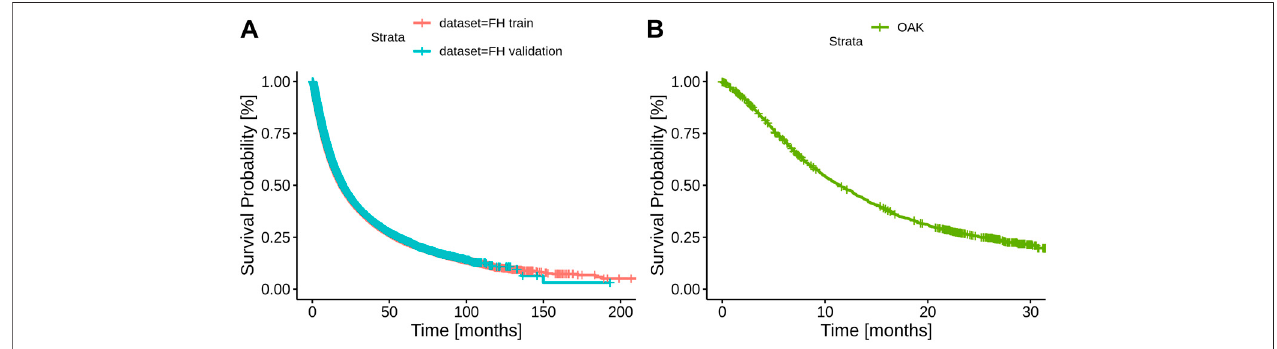
FIGURE 2 | Kaplan Meier curves of the datasets. (A) - Kaplan Meier curves for the FH train and test datasets. (B) - Kaplan Meier curve for the OAK test